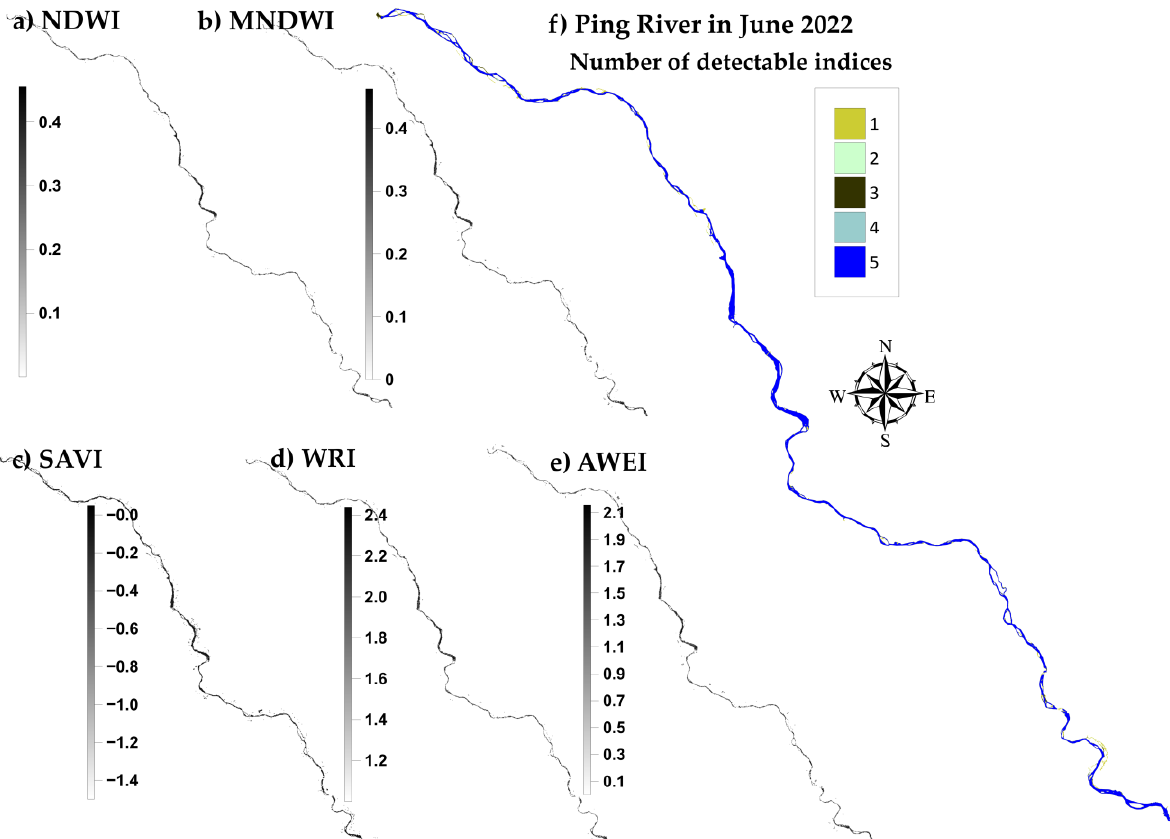
Figure 8. Stream extracted from Sentinel-2A images in 2022 using ( a ) NDWI, ( b ) MNDWI, ( c ) SAVI, ( d ) WRI, ( e ) AWEI, and ( f ) river shape with a number of detectable indices. Number 1 means only one index could detect. Numbers 2, 3, and 4 denote the area that 2, 3, and 4 indices could detect, respectively. Number 5 denotes the area that all water indices classify as Ping River.